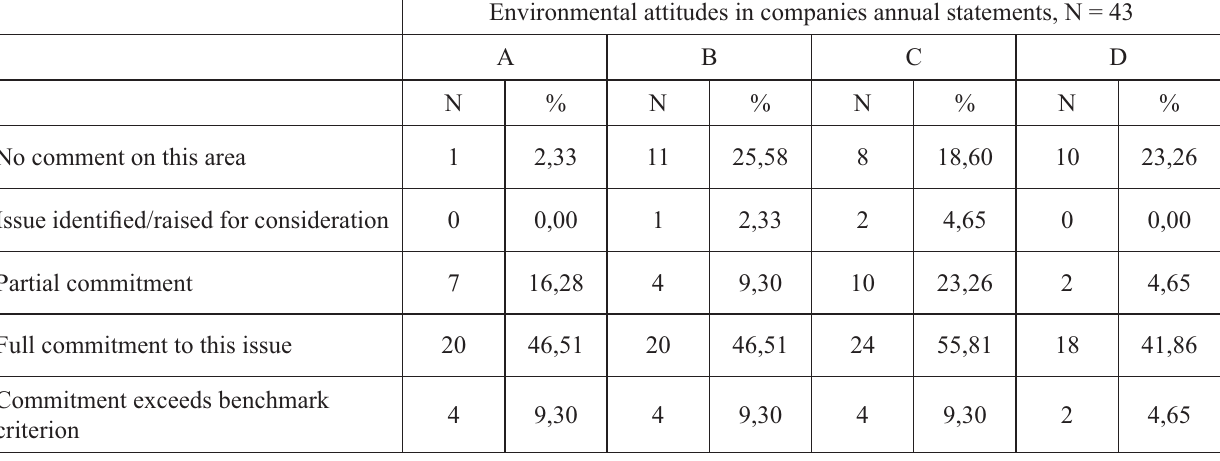
Table 3. MNEs environmental disclosure (frequency in count and